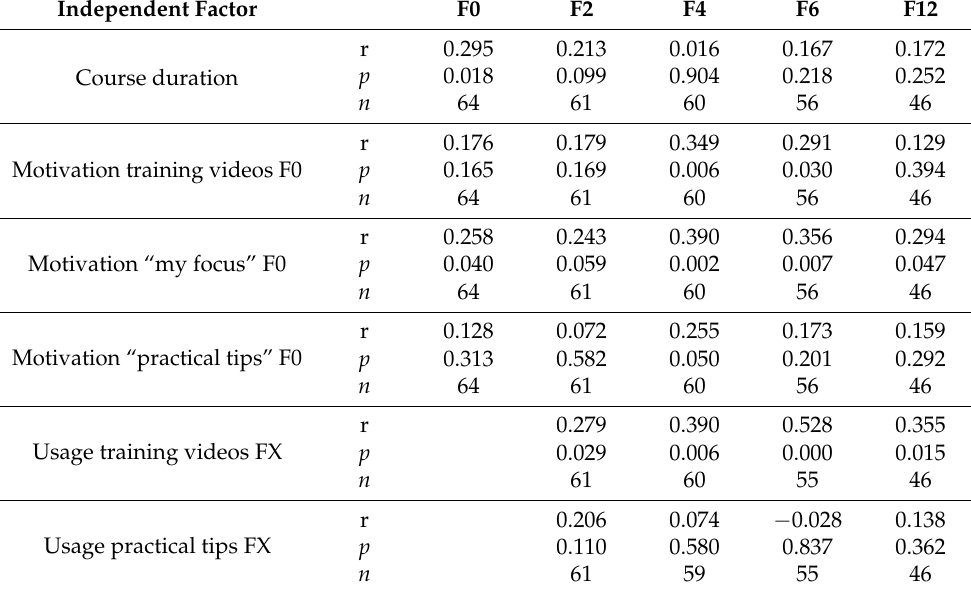
Table A6. Spearman-Rho Test for measuring correlations: Influence of different factors on physical activity (MET-minutes per week) at the follow-up measurement